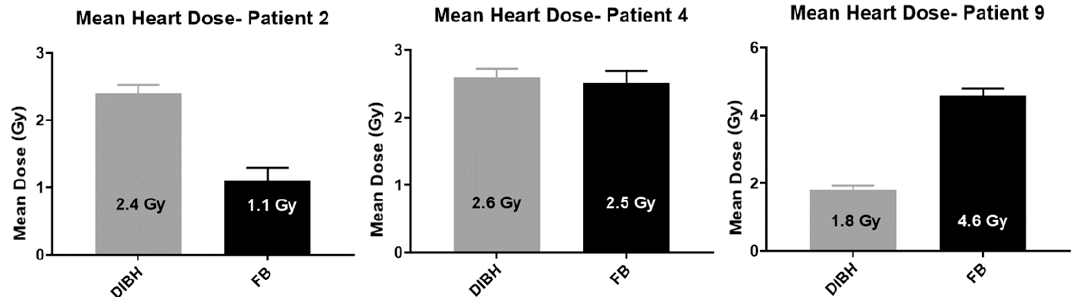
Figure 5. Variation of individual patient mean heart dose comparison results.